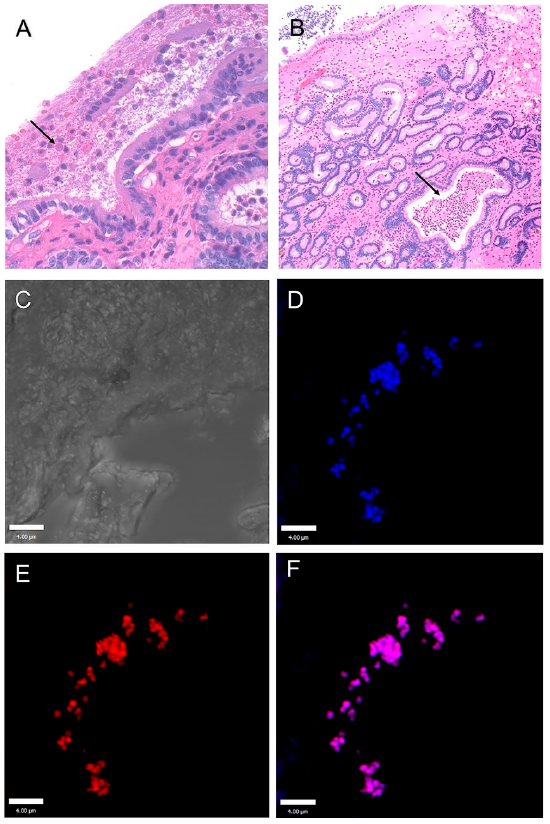
Figure 5. Detection of tissue-adherent P. aeruginosa in endometrium samples. H&E image of the endometrium with tissue-adherent P. aeruginosa on the luminal surface (black arrow) ( A ) and deep in the endometrial glands (black arrow) ( B ). ( C ) Differential interference contrast image of an endometrial gland below the luminal surface of the uterus; this is similar to the area represented in panel B by the black arrow. Immunofluorescent staining of tissue-adherent P. aeruginosa with an anti- Pseudomonas antibody (Alexa Fluor 405) ( D ) and anti-Pel lectin (Texas red) ( E ) and merged image detecting the Pel exopolysaccharide colocalized with P. aeruginosa ( F ). Immunofluorescent images are projected images of Z-stacks as processed by Volocity image analysis software in which 0.5- μ m scanning increments were performed through approximately 10 μ m of tissue. The scale bar is 4 μ m. Reprinted from: Ferris et al. 2017 [64].